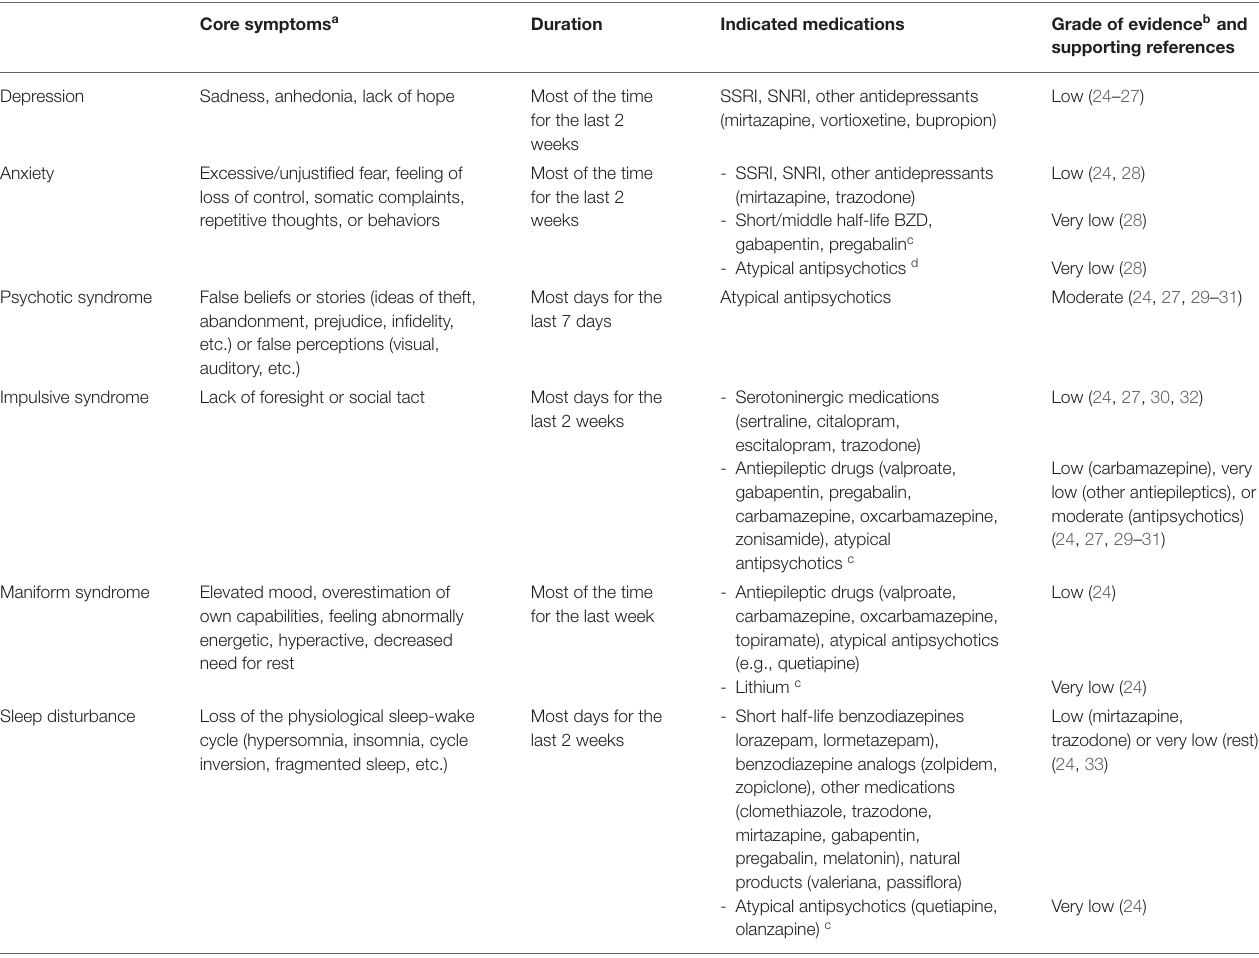
TABLE 2 | CHROME syndromes and indicated